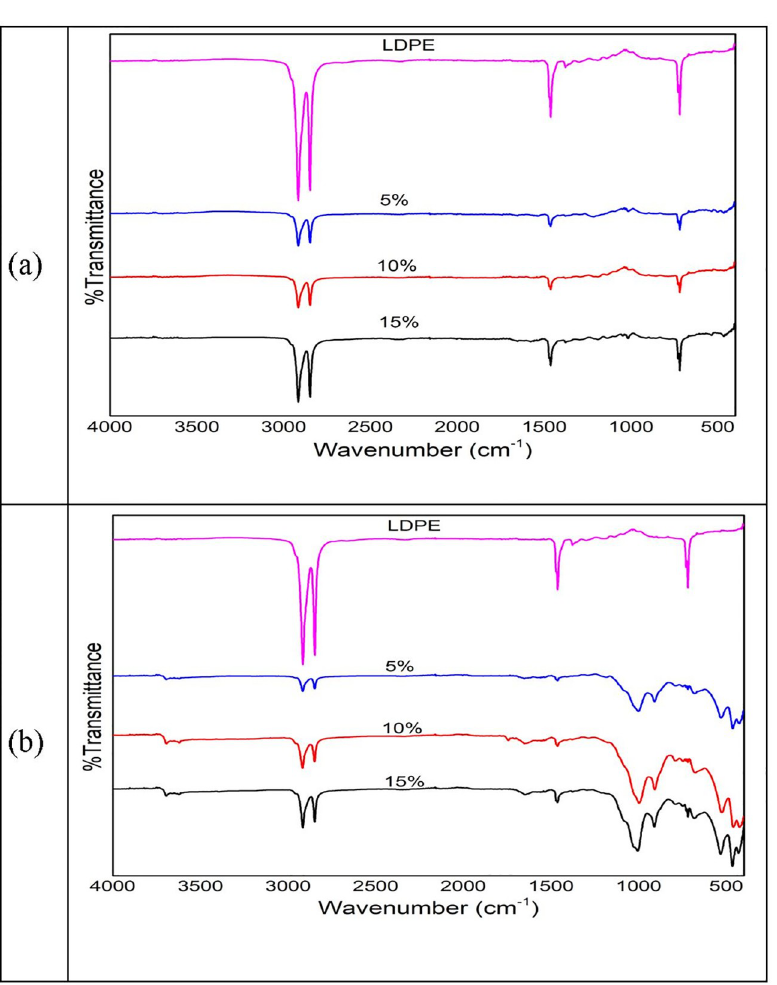
Fig 10. ATR spectra of neat LDPE and the three WPCs before (a) and after being buried in the soil for 50 days (b). https://doi.org/10.1371/journal.pone.0236406.g010 examined and demonstrated excellent characteristics as compared to those of conventional standard particleboard. Evaluation of WPCs mechanical properties produced a higher MOE but lower both MOR and IB. WPCs degradation was evaluated by the graveyard test and an assay test in termites. WPCs deteriorated in nature as shown by their discoloration after being buried in the soil and through a spectra alteration of ATR in the band of 500–1000 cm -1 which could be assigned to detach the interphase between wood and plastics. As termite bait, the WPCs showed continual weight loss, even though the mass loss was very small. Detailed spec- tra of LDPE inside termite guts provide evidence that WPCs can be consumed by termites. This provides important evidence that plastics can be degraded by insects like termites in nature, though only broken up into microplastics, rather than completely biodegraded. Even Table 5. Results of DTA examination on LDPE and WPC with various compounds. Type of